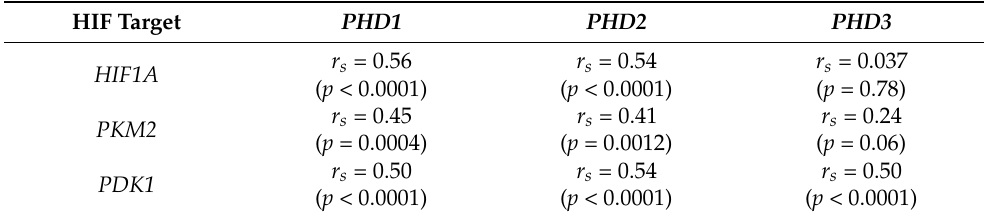
Table 2. Spearman’s rank correlation coefficient analysis of associations between PHD1 , PHD2